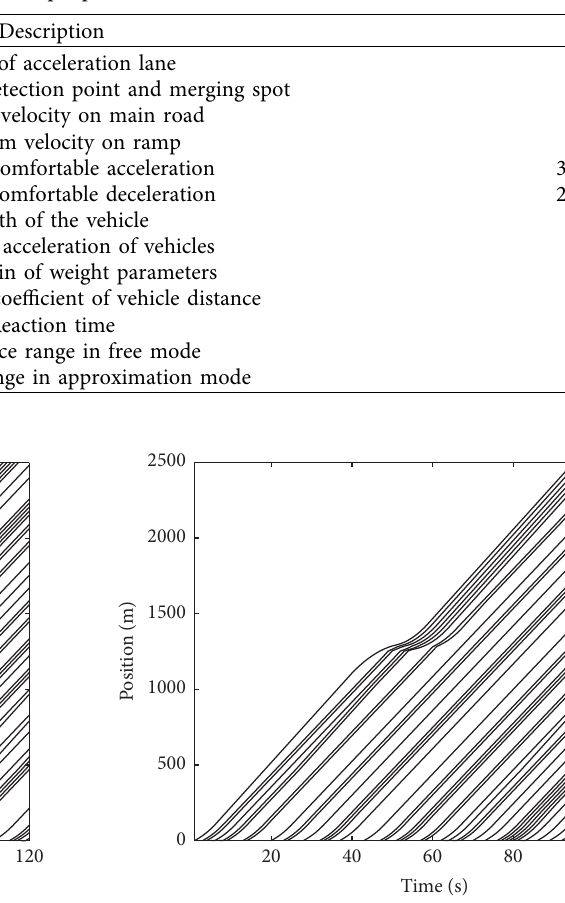
Figure 5: Trajectories without merging vehicles.